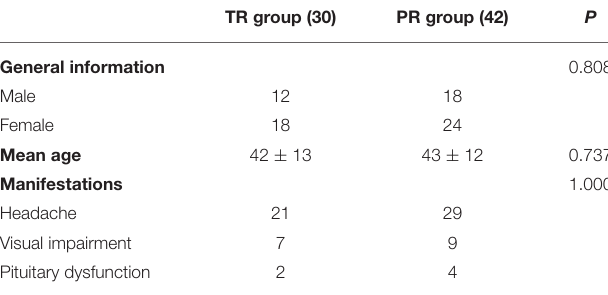
TABLE 1 | Clinical presentations of 72 Patients with